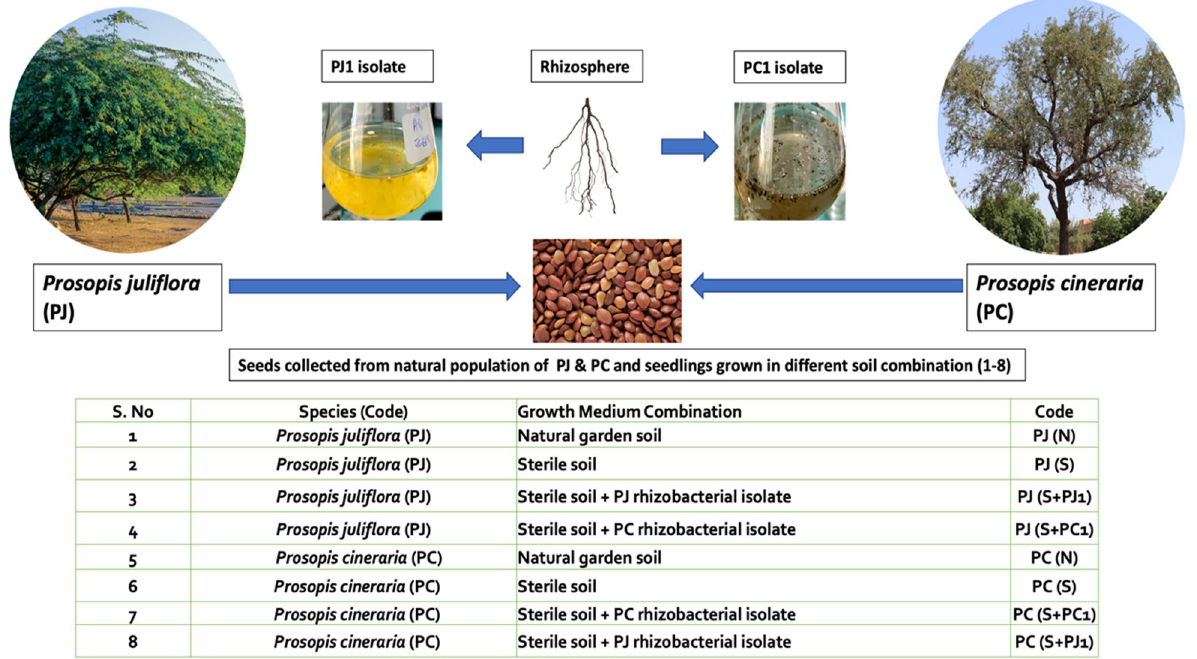
Fig. 1 Experimental design. Rhizosphere bacterial isolates obtained from the native Prosopis cineraria (PC1) and invasive Prosopis juliflora (PJ1) were used for soil inoculation in different combinations (1–8) as indicated